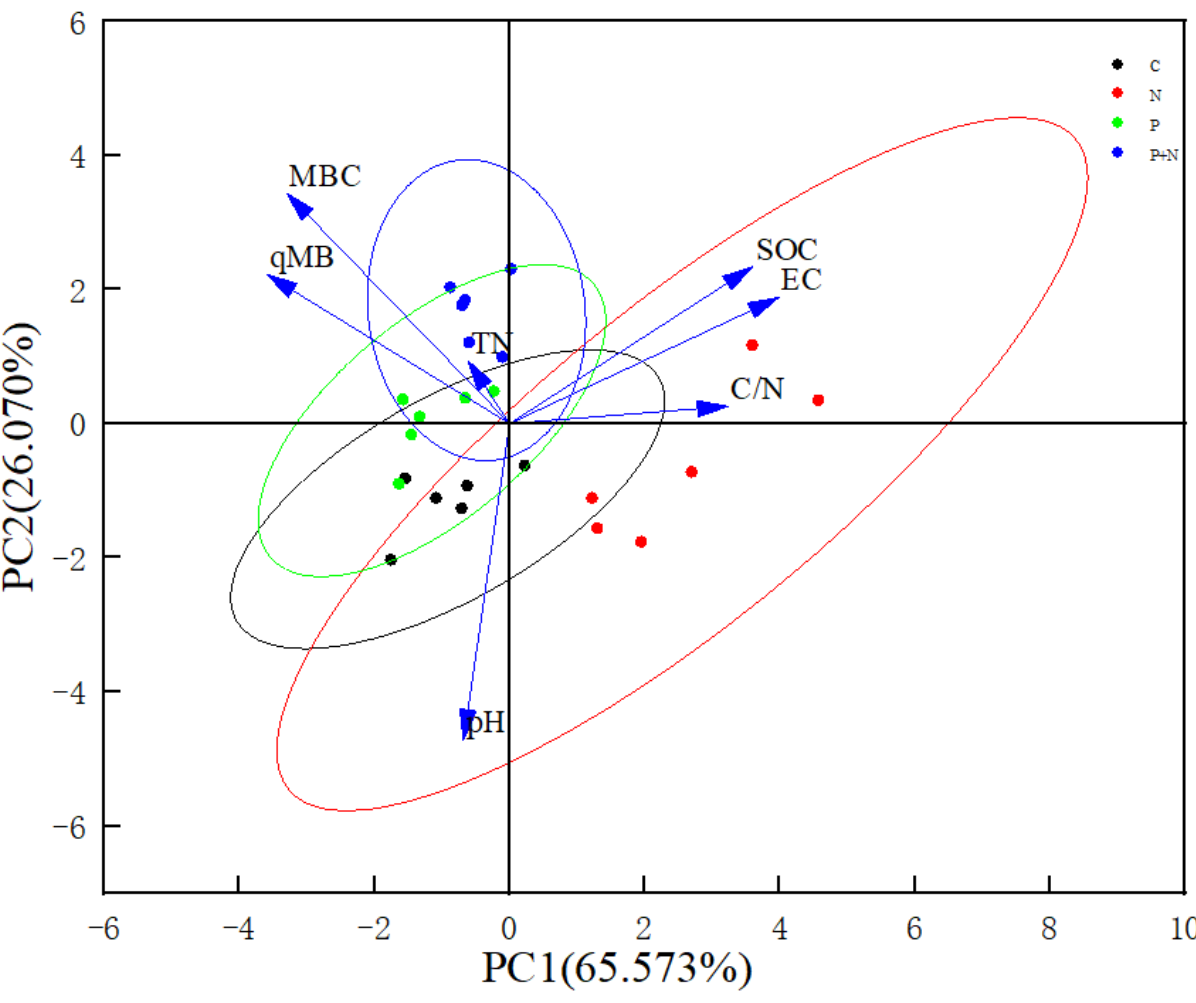
Figure 6. Principal component analysis of desert steppe. Table 5. Comprehensive scores of soil quality of different grassland